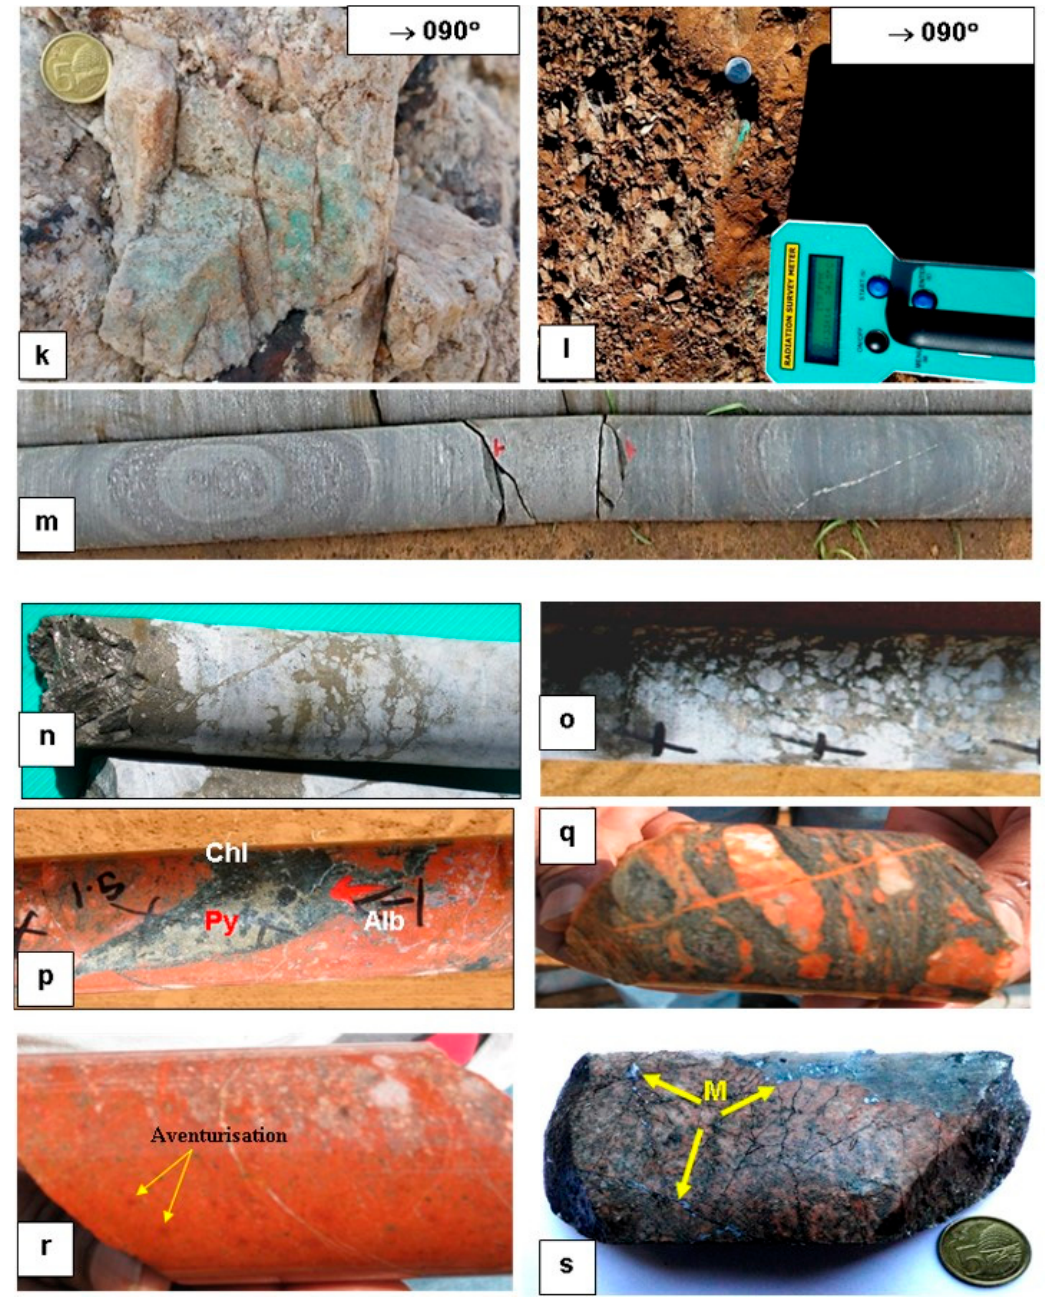
Figure 5. Field observations. ( a ) Tight to isoclinals F 1 folds refolded to F 2 in quartzite bands housed within the schist, coin dia. 2.3 cm, vertical section orthogonal to fold axis, viewing south; ( b ) the development of crenulations on S 1 of the QFBS that define crenulation cleavage; the cleavage is axial planar to F 2 folds developed in the quartzite bands on bottom left part of the photograph, coin dia. 1 cm, vertical section orthogonal to fold axis, viewing south; ( c ) sketch of the crenulations with an enlarged view of the demarcated block in ( b ); ( d ) the QFBS showing strong foliations parallel to the pencil, steeply dipping towards SW (84° → 245°); this foliation is parallel to the F 2 axial surfaces, vertical section viewing 335°; ( e ) intercalations of quartzite bands with the QFBS that are strongly folded; bedding (S 0 ), foliations (S 1 and S 2 ) are strongly parallel, vertical section orthogonal to strike of bedding and foliation, viewing south; ( f ) strong preferred orientation of elongated quartz grains parallel to the cleavage planes (S 1 parallel to S 2 ), vertical section normal to strike of the cleavage, viewing 175°; ( g ) D 3 deformation has led to gentle warping (F 3 ) on thinly banded quar tz ite with an EW trending axial trace, plan view; ( h ) heavily jointed quar tz ites with the development of conjugate shear fractures, vertical section viewing N350°; ( i ) fault breccias in quar tz ites, note the angular